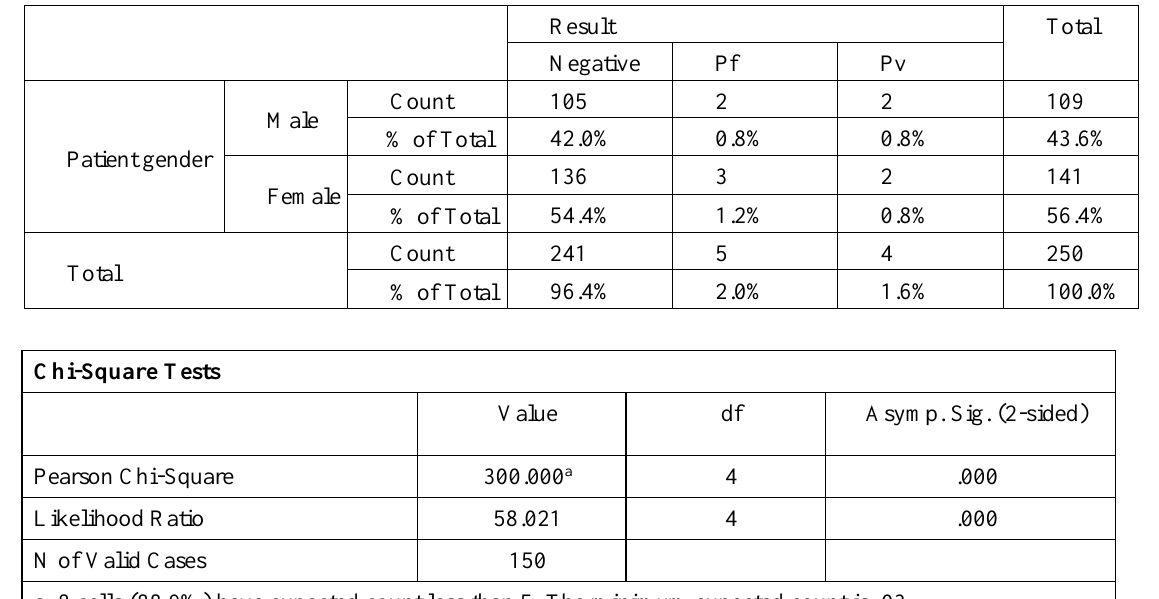
Table3 . Prevalence rate of species of malaria infection among patients attending hospital and health centers according to gender.